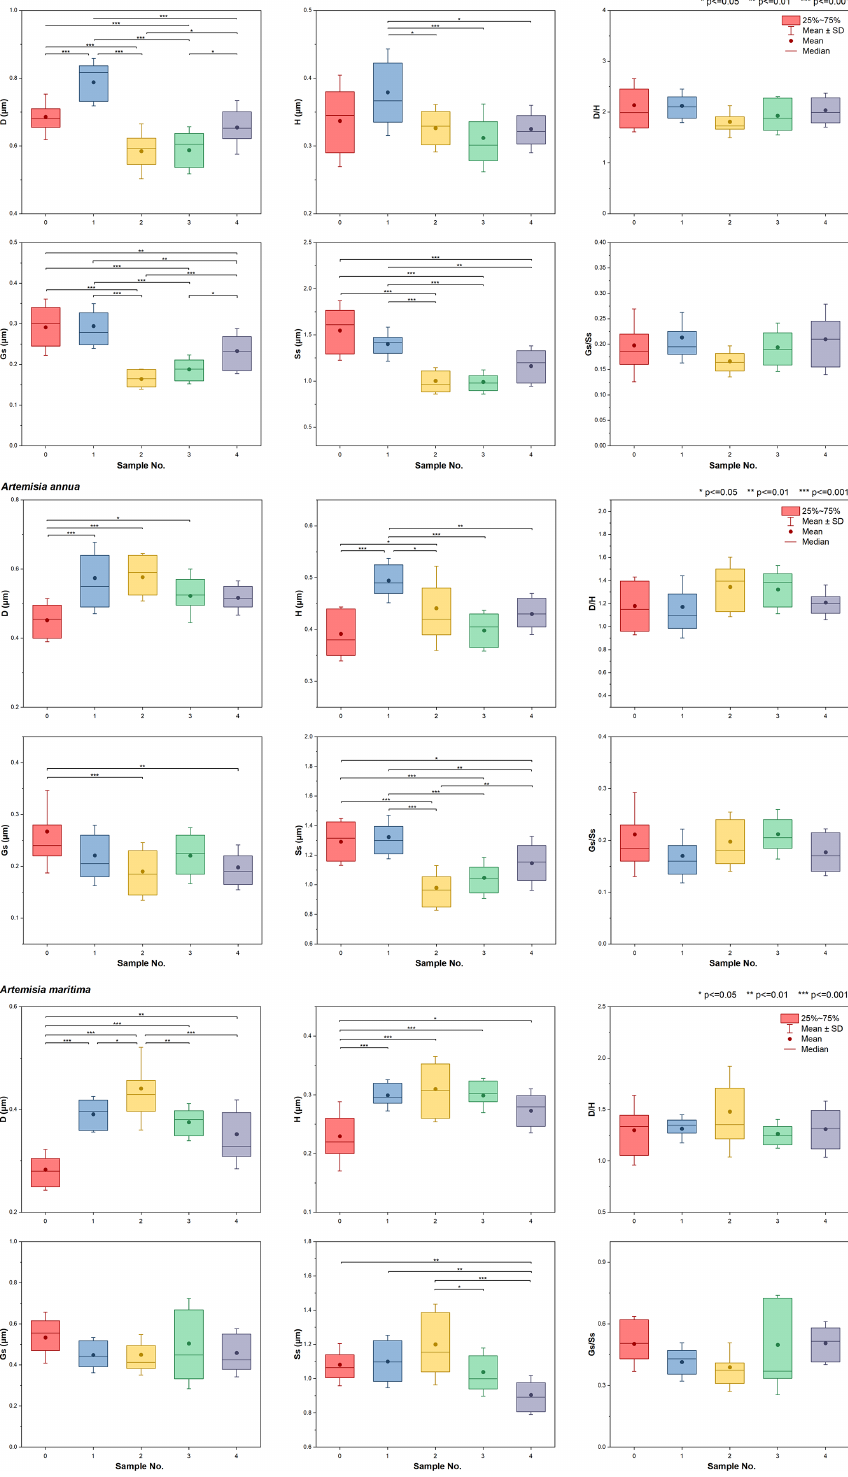
Figure 20. Boxplots of intraspecific pollen exine ultrastructure characters from three species of Artemisia , showing the variations (M ± SD) in six pollen characters ( D : diameter of spinule base; H : spinule height; Gs: granule spacing; Ss: spinule spacing; Ps: perforation spacing). Asterisks indicate statistically significant differences ( ∗ p ≤ 0 . 05, ∗∗ p ≤ 0 . 01, ∗∗∗ p < 0 . 001).